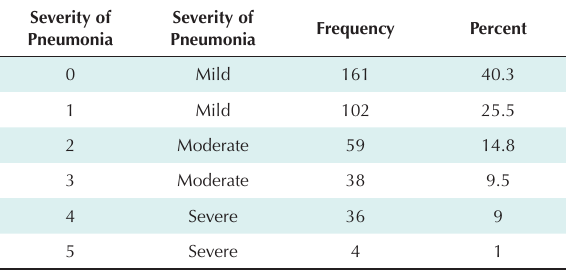
Table1. Frequency of the Severity of Pneumonia